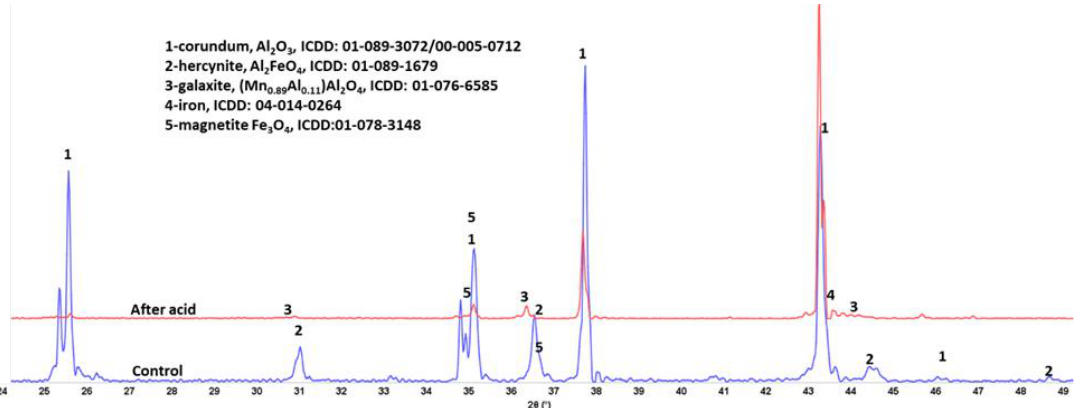
Figure 16. XRD patterns of the control (250 °C autoclaved) and acid-exposed anorthite samples.